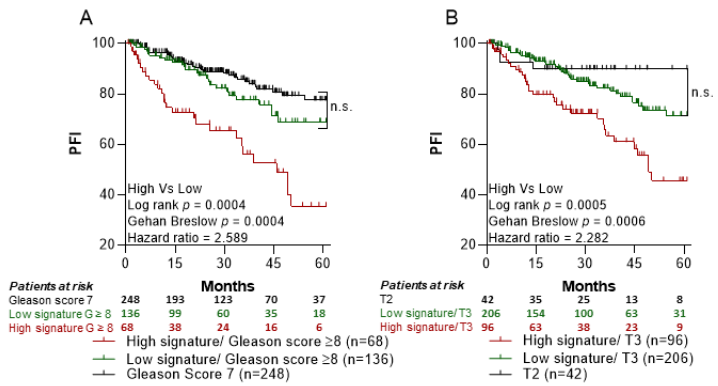
Figure 4. Prognostic potential of the 6-GS in PCa patients. Kaplan-Meier curves for Progression Free Interval (PFI) were designed based on the median expression of the 6-GS in prostate tumor tissue in association with poor clinicopathological parameters. Moreover, the number of patients at risk are presented in the graph. ( A ) No significant difference in PFI among patients with high Gleason score ( ≥8 ) and low expression (below median) of the 6-GS (green line; n = 136) and patients with intermediate Gleason score (7) (black line; n = 248). In the same lines, ( B ) the PFI in the group of patients with unfavorable T3 stage (3a,3b) and low expression of the 6-GS (green line, n = 206) did not differ statistically as compared to PFI in patients with more favorable T2 stage (2a – 2c) (black line, n = 42). Patients with high expression of the 6- GS (above median) having either Gleason score ≥8 ( A ) or T3 stage (3a,3b) ( B ) (red lines; n = 68 and n = 96 for A and B, respectively) had a significantly worse PFI as compared to patients with low expression of the 6-GS (green lines). n.s.: non significance.